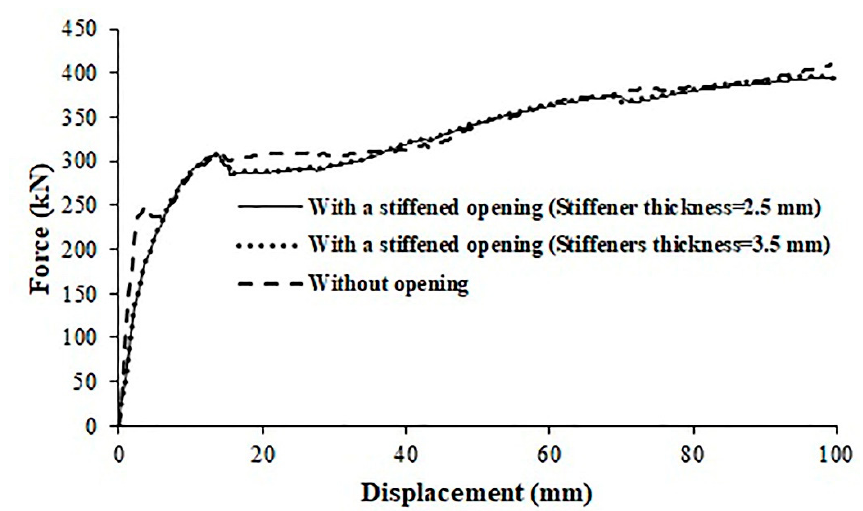
Figure 25. Force-displacement curves of three corrugated steel infill panels.